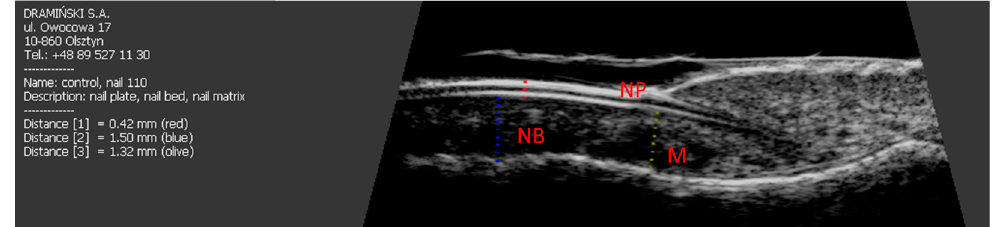
Figure 3. Longitudinal scan of a healthy nail. NB: nail bed, NP: nail plate, M: nail matrix. In patients with Enth (+) and Enth ( − ), regression of nail changes assessed with mNAPSI index was found in 82% and 87% of the patients, respectively. The reduced severity of clinical nail changes after retinoid treatment did not correlate with the reduction in extensor tendon thickness (Figure 4).